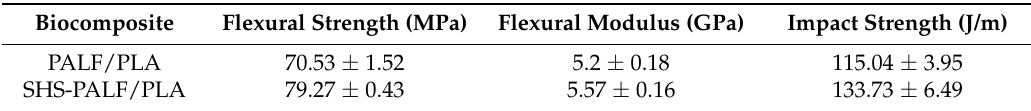
Table 3. Flexural strength, flexural modulus, and impact strength of PALF/PLA and SHS-PALF/PLA biocomposites.